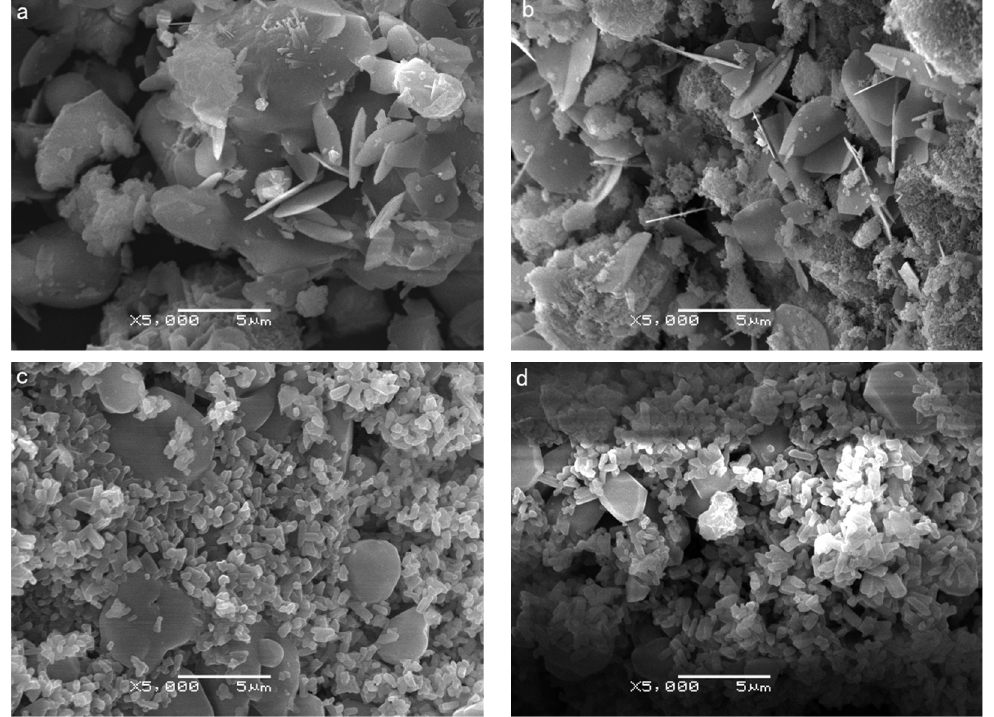
Figure 2. SEM images of KGP ceramics. ( a ) 1200 °C, 4 h, without KCl salt; ( b )1200 °C, 8 h, without KCl salt; ( c ) 900 °C, 4 h with salt (LC4); ( d ) 900 °C, 8 h with salt